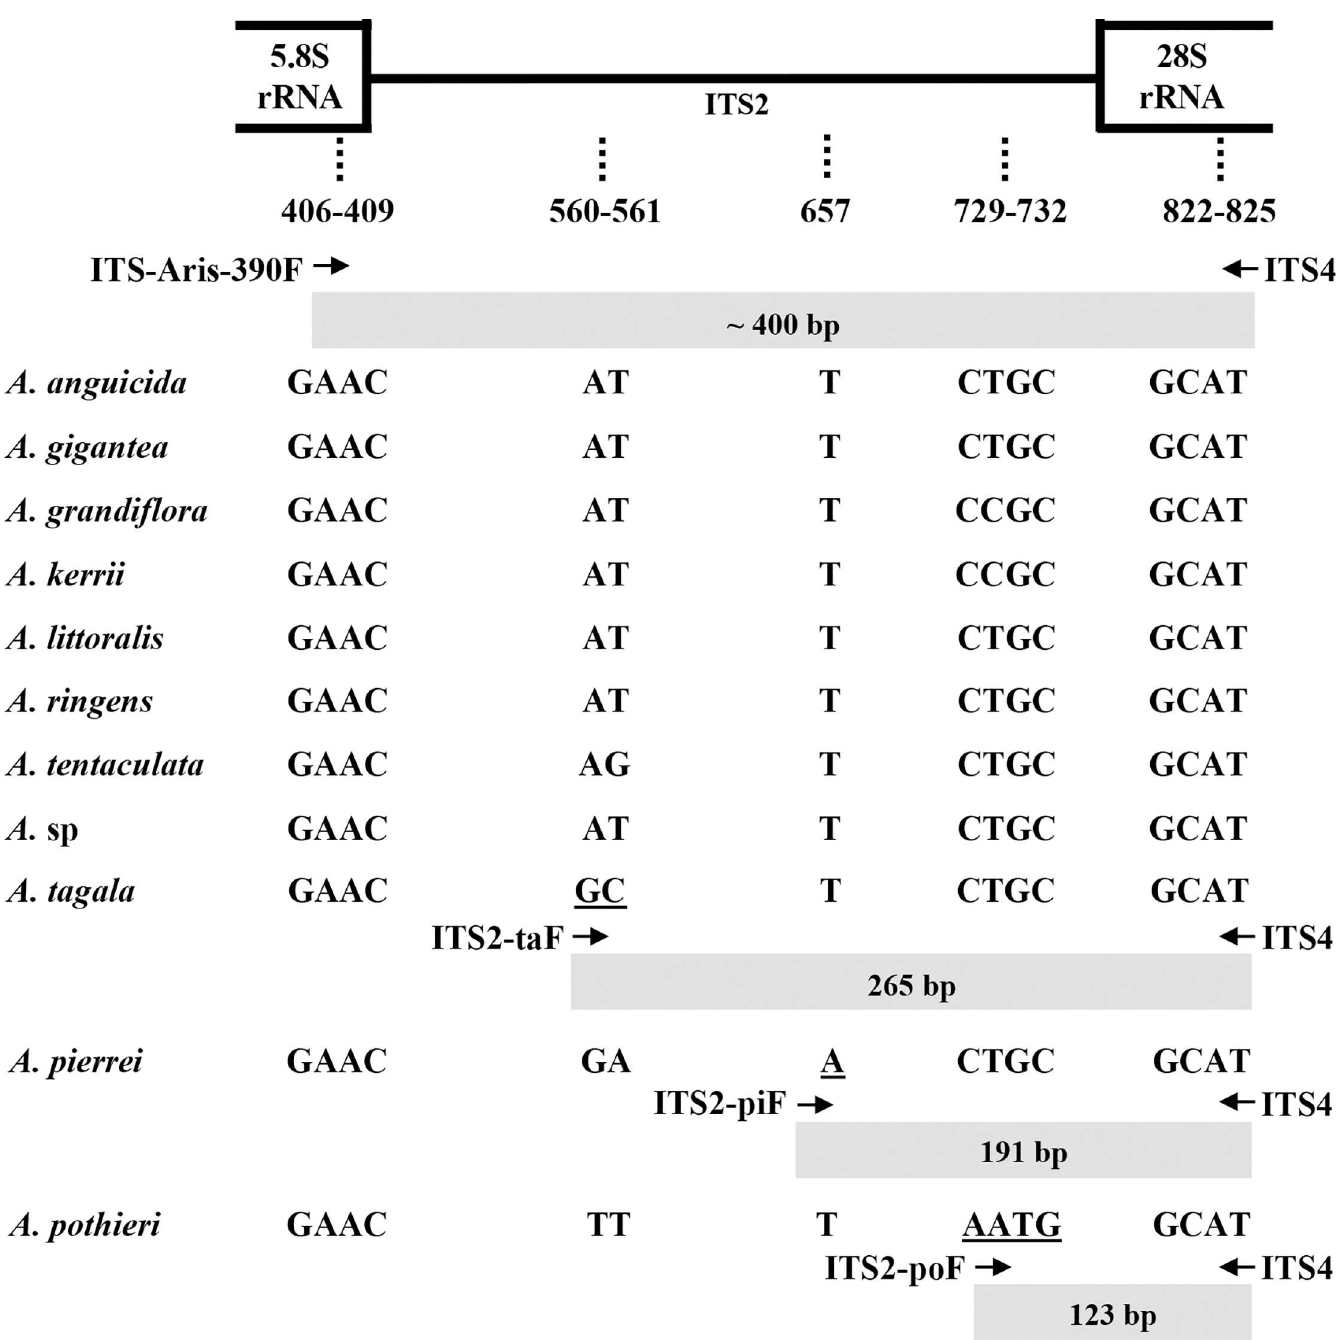
Fig 1. A schematic diagram of the ITS2 region in eleven Aristolochia species and related species. Dotted lines represent the positions of diagnostic nucleotides. Underlined nucleotides represent the species-specific 3’ ends of the primers. Arrows indicate the orientations and approximate positions of the species-specific primers. The grey boxes represent the PCR products from multiplex